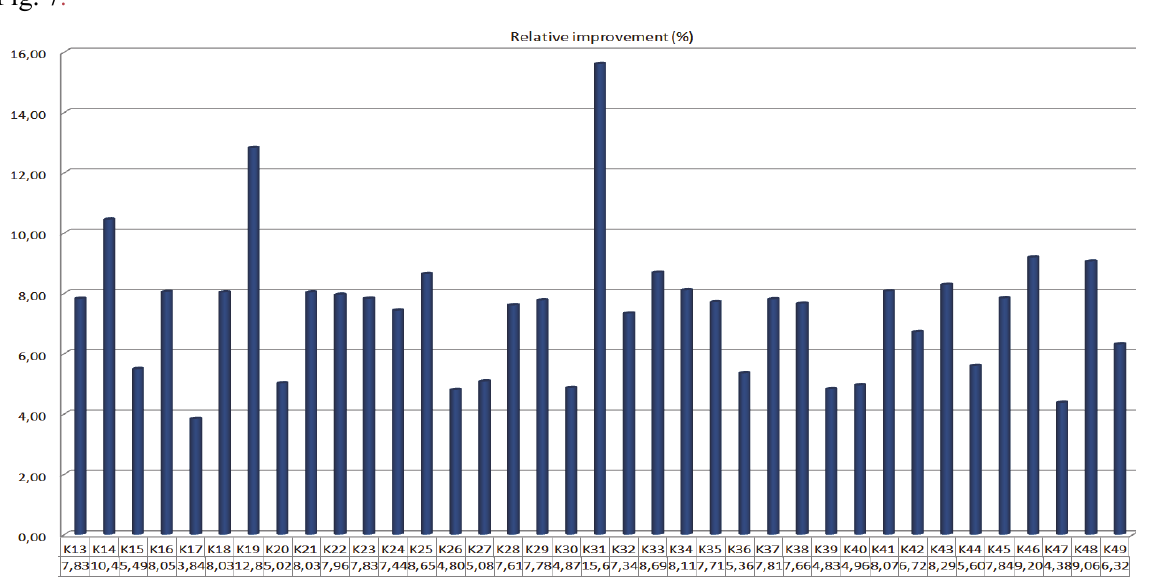
Fig 7. Relative improvement offered by SO solutions compared to deterministic solutions The average improvement value was equal to 7.43% and the maximum improvement was as high as 15.6%. Therefore, we can conclude that the use of SO solutions are very useful to achieve a good robustness against